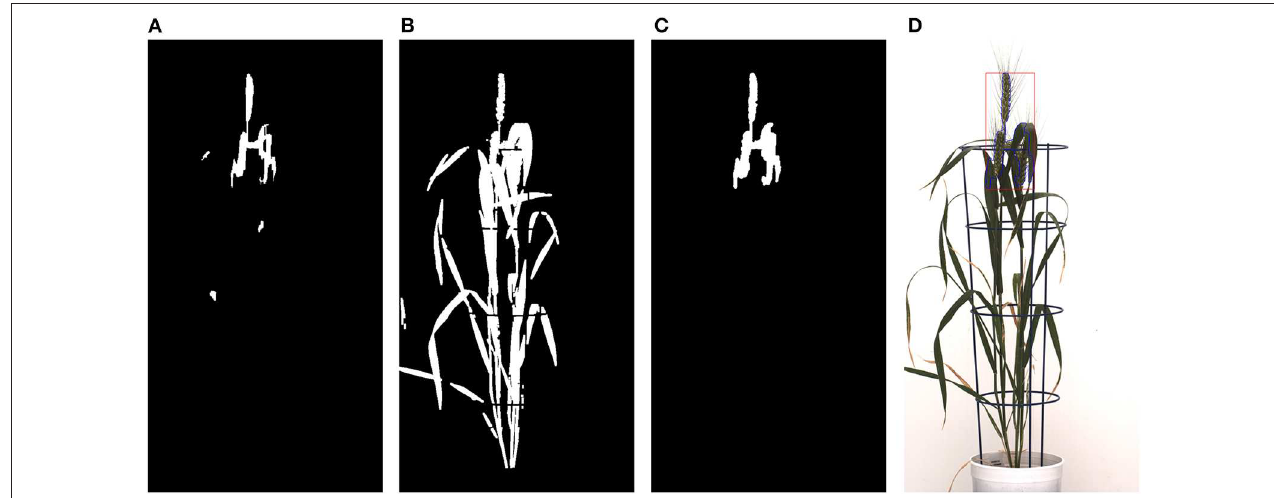
FIGURE 11 | Morphological reconstruction of the spikes: (A) Frangi-based spike segmentation. (B) CIS image. (C) Morphologically reconstructed image using (A,B) . (D) Spikes detected in the original image represented with blue lines and a red rectangular